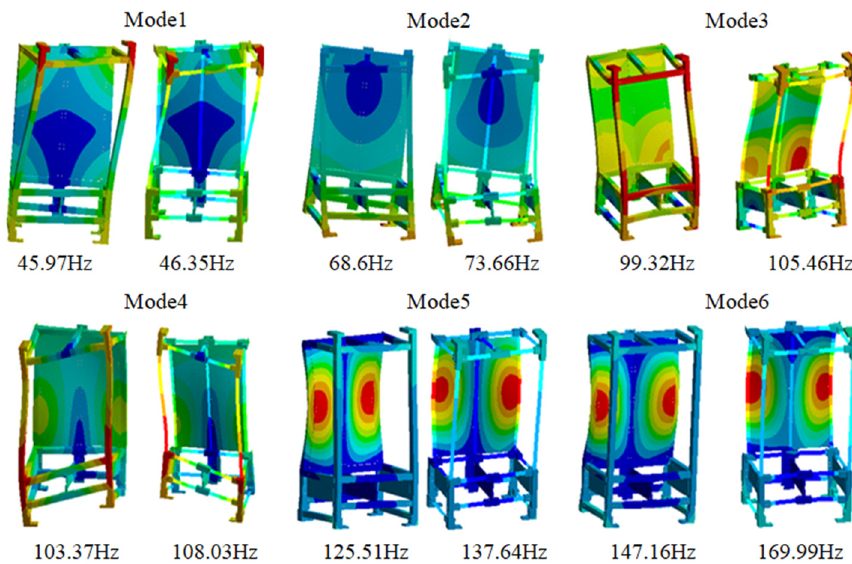
Figure 3. Calculated modal shapes of the experiment rack simulator .